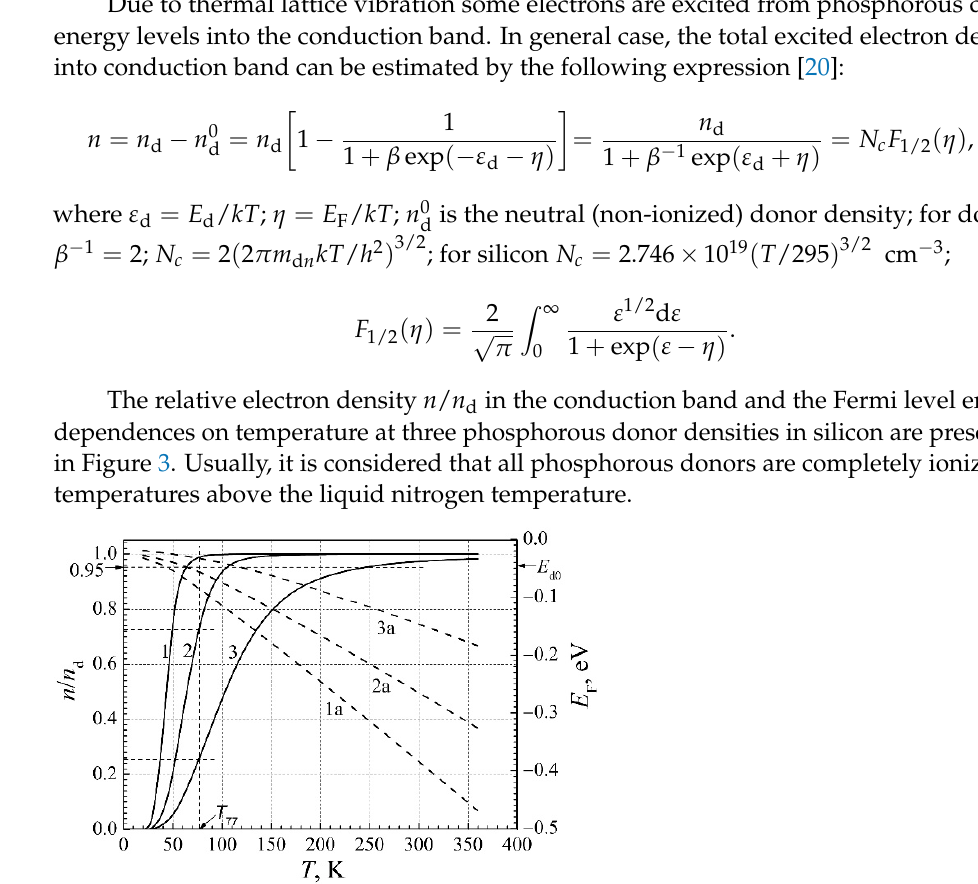
Figure 3. The total electron density in the conduction band n (left scale), and the Fermi level energy E F dependence on temperature at three phosphorous doping densities n d in silicon, in cm − 3 : 10 13 ; 10 15 ; 10 17 (the donor energy decrease with doping level increase is taken into account).